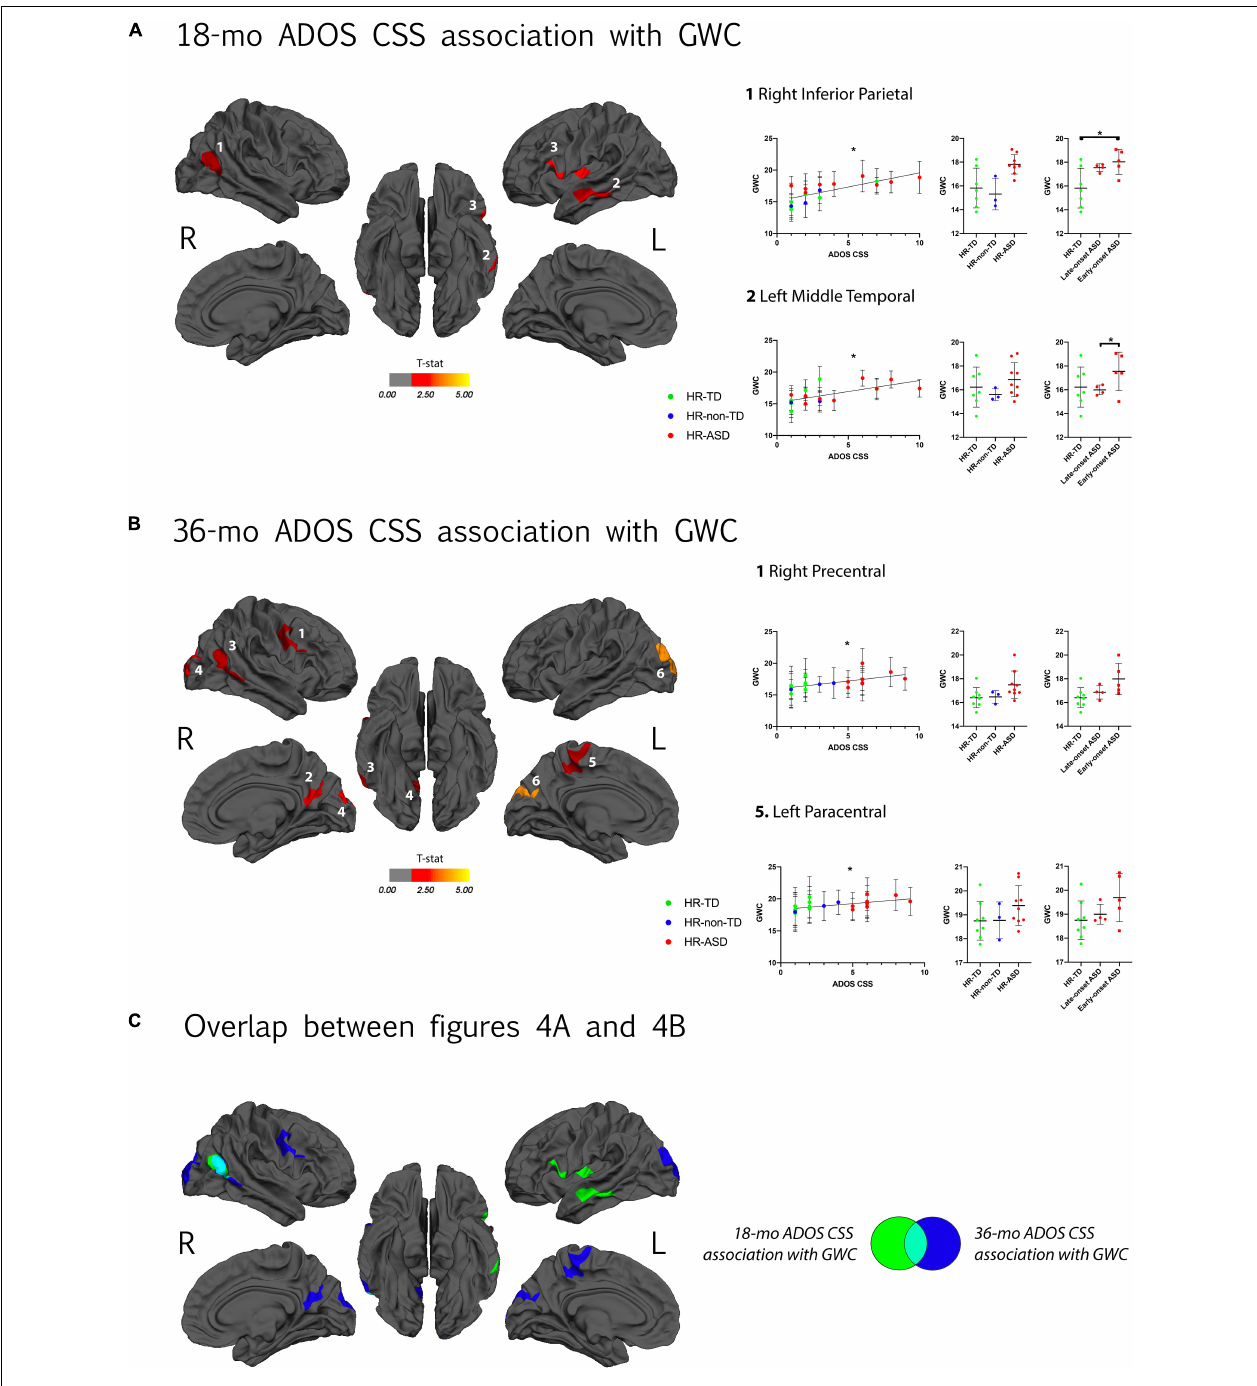
FIGURE 4 | (A) Clusters with a significant association between gray-white matter contrast (GWC) at age 12–24 months (computed as mean GWC between two scan acquisitions) and ADOS calibrated severity score (CSS) at 18 months of age. Only clusters with CWP < 0.05 after regression for age and correction for multiple comparisons are displayed. Color code corresponds to P -value of the vertex with maximal p -value (Pvm) of each cluster and is represented as T-stat values (see Table 2 ). Within each hemisphere, clusters are listed in order of decreasing effect size (Pearson’s R, see Table 2 ). On the right, individual mean GWC values are displayed in function of ADOS CSS for clusters with the greatest effect size. Same individual values are further plotted in function of diagnostic outcome group (HR-TD, HR-non-TD, and HR-ASD) in the middle graph. In the right graph, comparison between HR-TD and HR-ASD subgroups (LOA and EOA) are displayed. Similar graphs for all significant clusters are available in Supplementary Figure 3A . (B) Association between GWC at age 12–24 months of age and symptom severity at 36 months of age. Detailed results for all clusters are displayed in Supplementary Figure 3B . (C) Clusters of (A,B) displayed on a common template with color code corresponding to the age of clinical assessment (green for 18 and blue for 36 months of age). * p < 0.05.